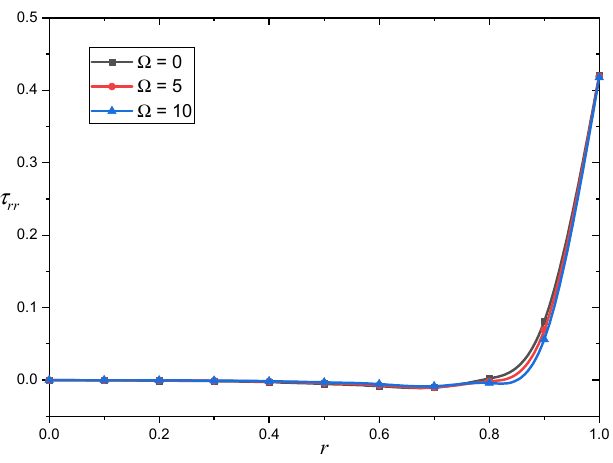
Figure 12. The Maxwell’s stress τ rr for different rotation parameter Ω Figure 12. The Maxwell’s stress (cid:2028) (cid:3045)(cid:3045) for different rotation parameter Ω . Figure 12. The Maxwell’s stress (cid:2028) (cid:3045)(cid:3045) for different rotation parameter Ω .